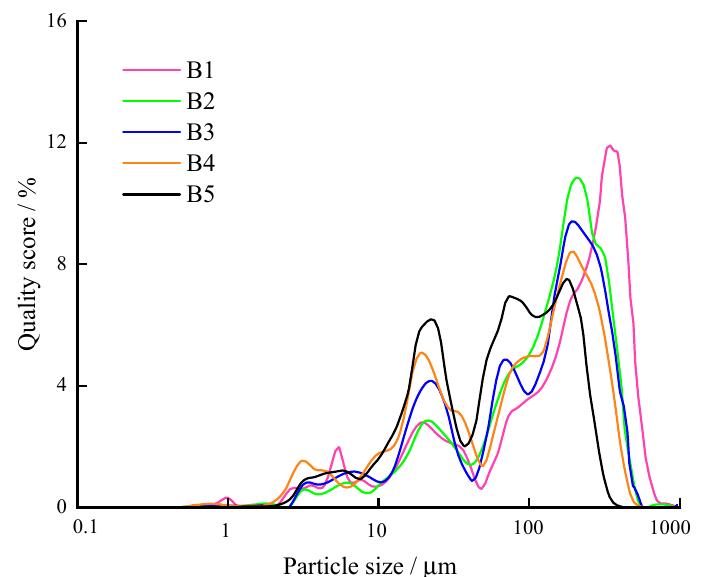
Figure 13. Coal powder particle size distribution under closure pressure 5 MPa and flow rate 300 mL/min.